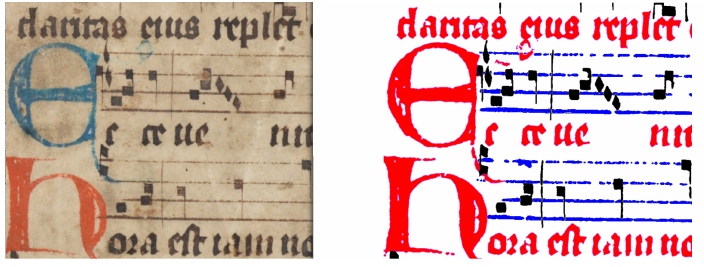
Figure 5. Example of a small portion from ground-truth data. The original image is used to extract the input feature blocks, while the labeled page indicates the categories to which each pixel belongs (white pixels mean background , black pixels mean notes , blue pixels mean staff line , and red pixels mean text